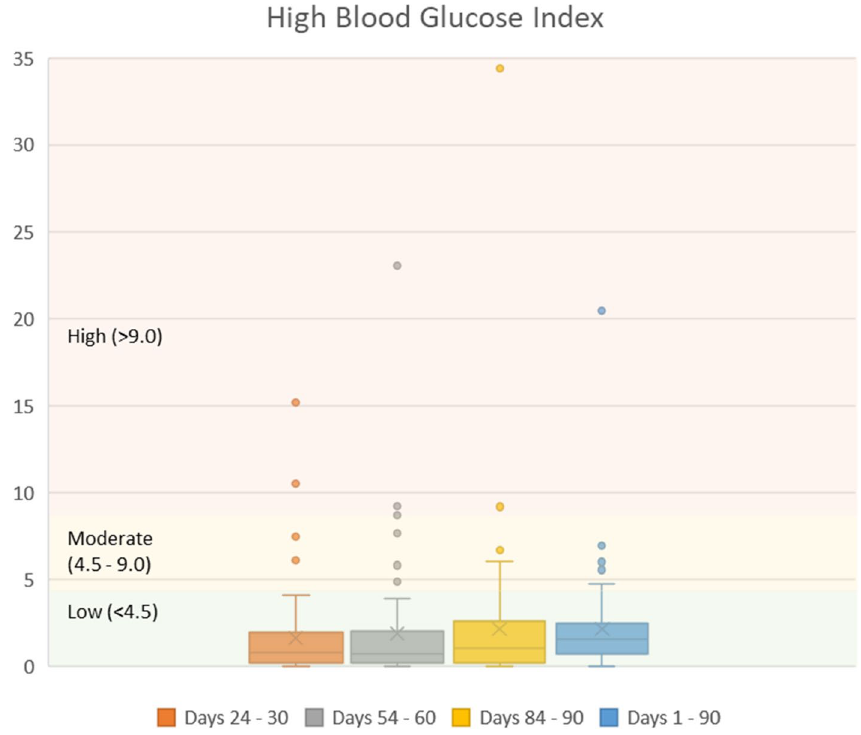
Figure 5. High blood glucose index during the first 90 days of program